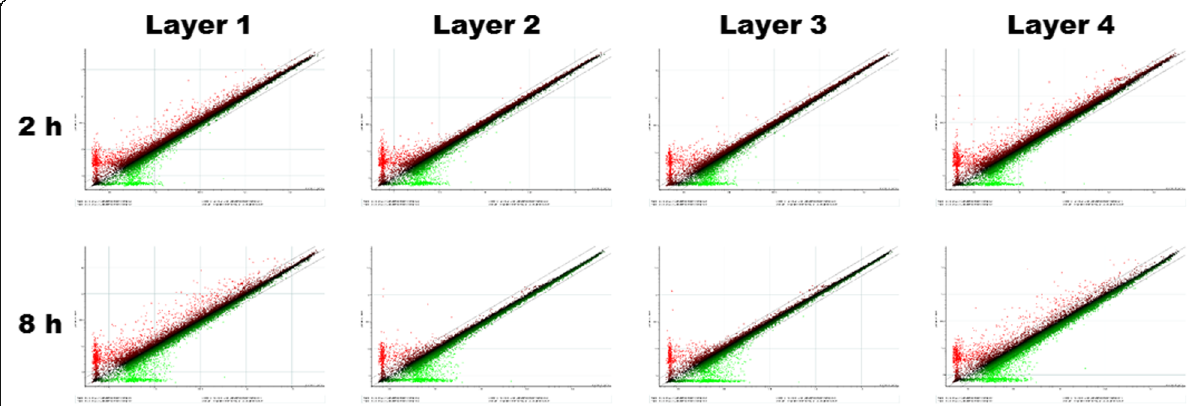
Fig. 1 A sigma plot for each group. The gene expression ratio between saline control and each silk mat layer is shown as a single spot. Most gene data were collected on the line having inclination of 1.0. The number of genes that underwent more than 2-fold changes in expression was much greater in layer 1 and 4 groups than in layer 2 and 3 groups